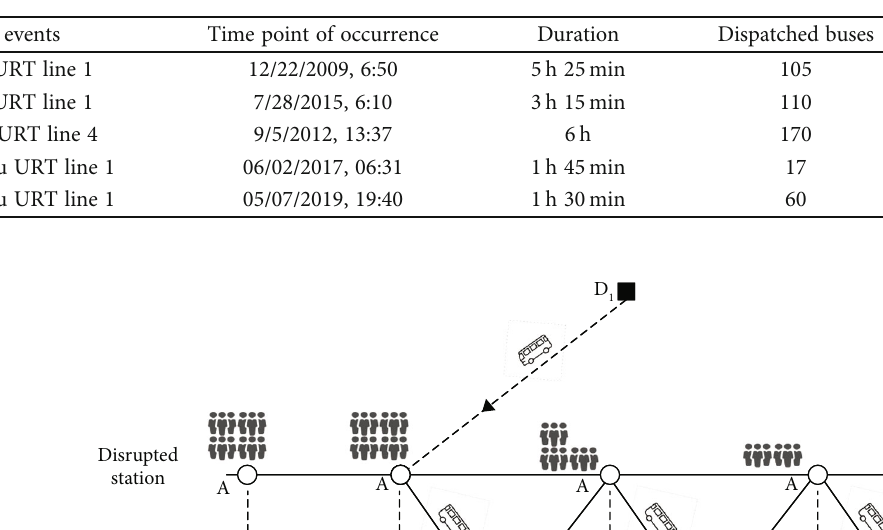
Table 1: Some applying cases of bus bridging service in